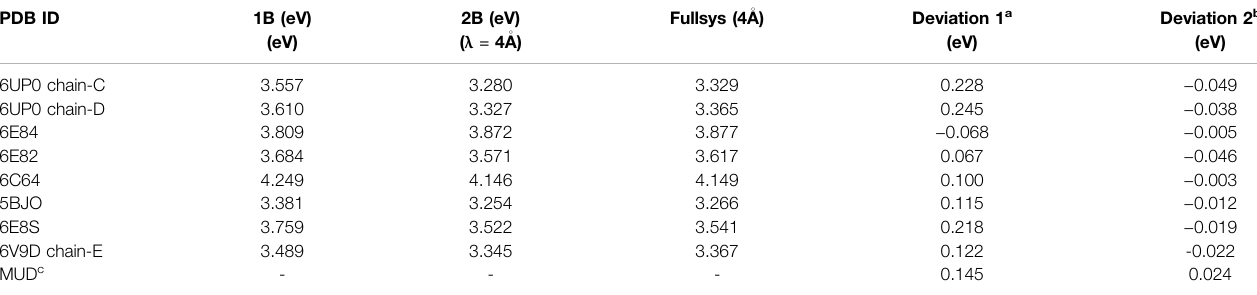
TABLE 4| Comparisonofthecalculatedexcitationenergiesforaseriesof fl uorescentRNA – aptamersystemsbetweentheEE-GMFCC ( λ 2B (cid:2) 4 (cid:1) A)andtruncatedfull-system calculations at the TD-HF/6-31G* level. The model systems constructed with λ FS (cid:2) 4 (cid:1) A for all fl uorescent RNA – aptamer systems are utilized here. PDB ID